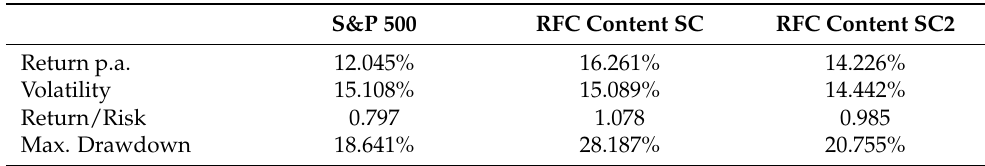
RFC Content SC RFC Content SC2